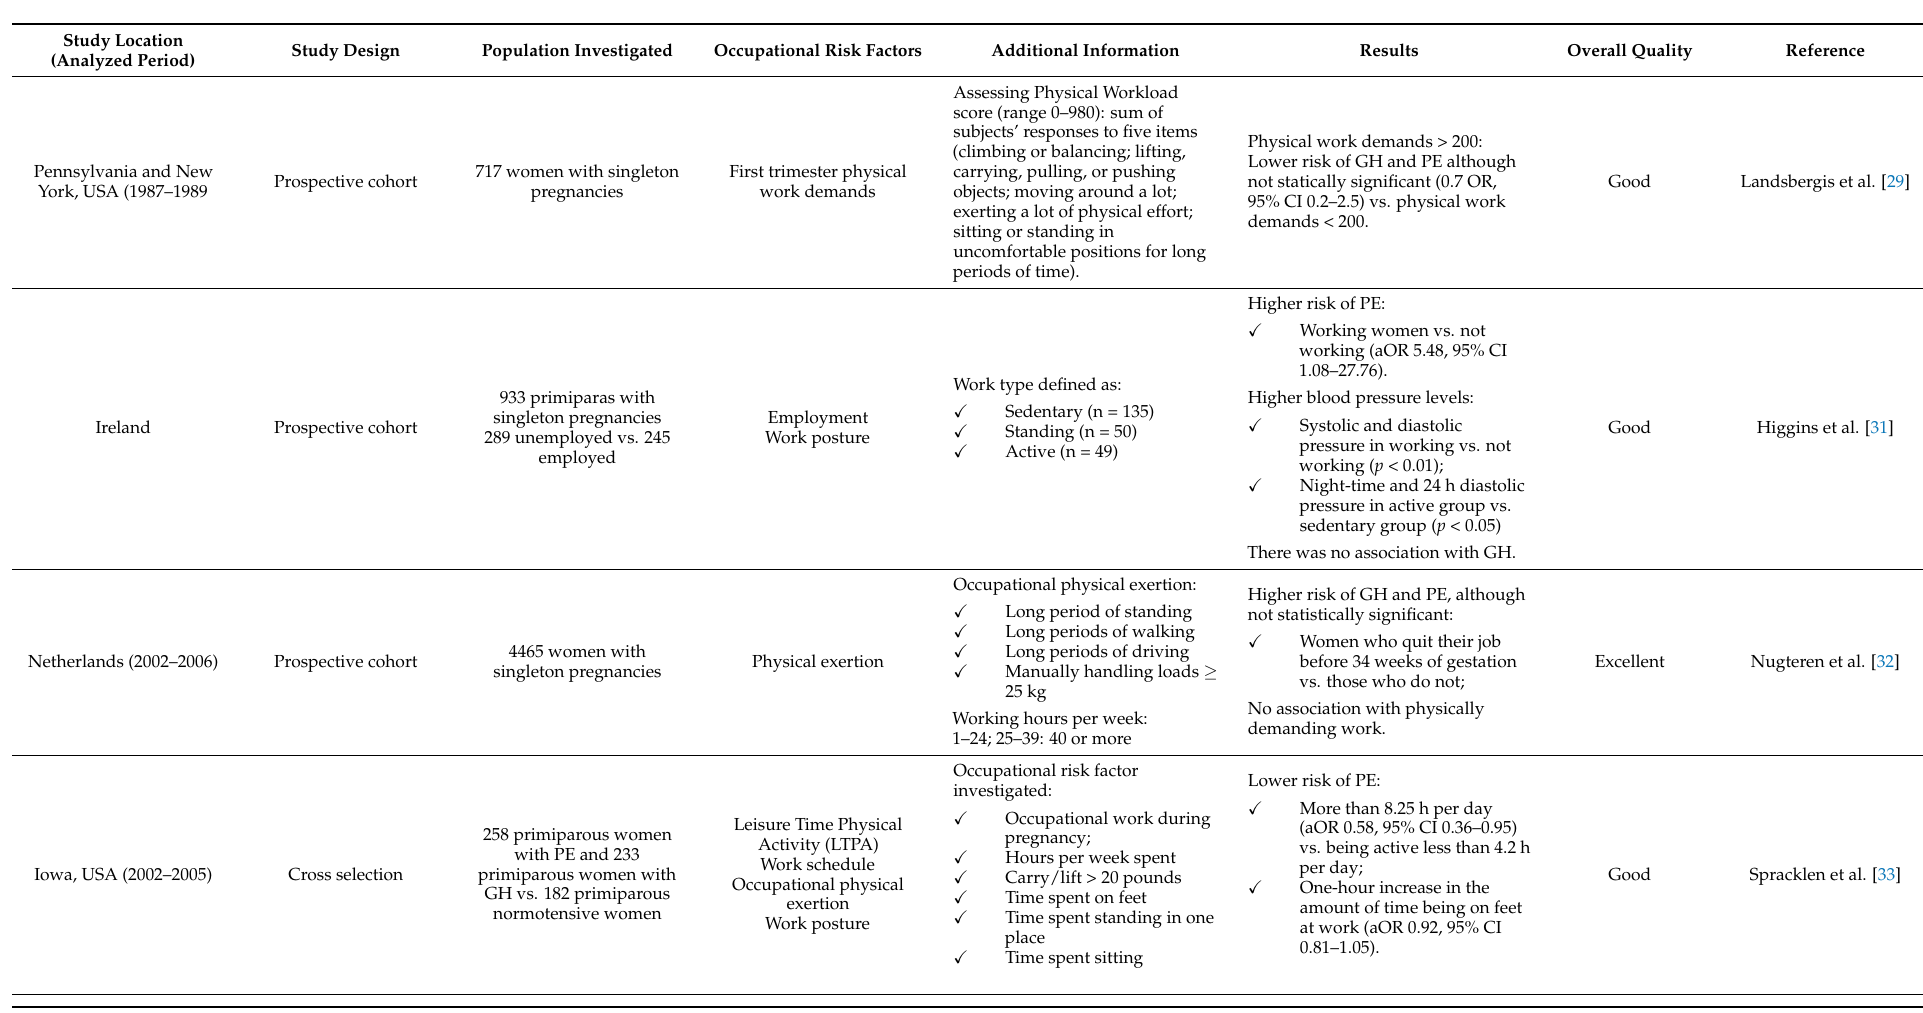
Table 4. Studies assessing the relationship between hypertensive disorders in pregnancy (HDP), including preeclampsia (PE) and gestational hypertension (GH), and exposure to physical